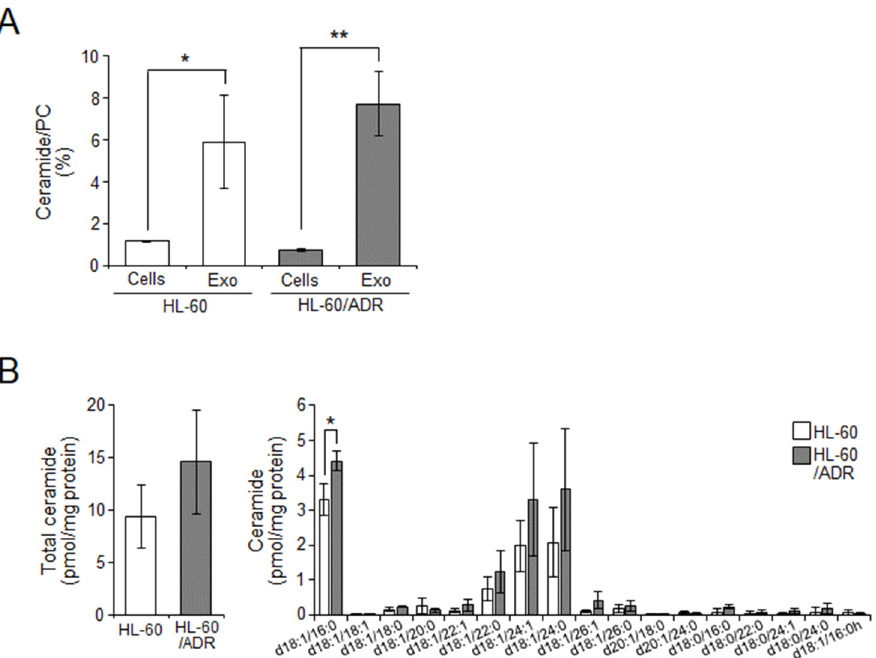
Figure 2. Ceramide contents in exosomes. Exosomal and cellular ceramides were measured by LC-MS/MS. ( A ) The ratio of ceramides was calculated by the amounts of phosphatidylcholine (PC). ( B ) Ceramide contents in exosomes. Values indicate mean ± SD ( n = 3). * p < 0.05, ** p < 0.005.